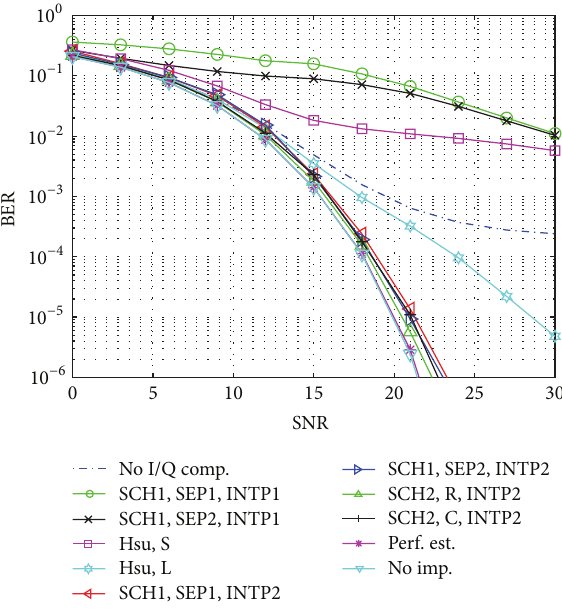
Figure 10: BER performance as a function of SNR, 𝑁 = = 17 . 256 and 𝑁 0